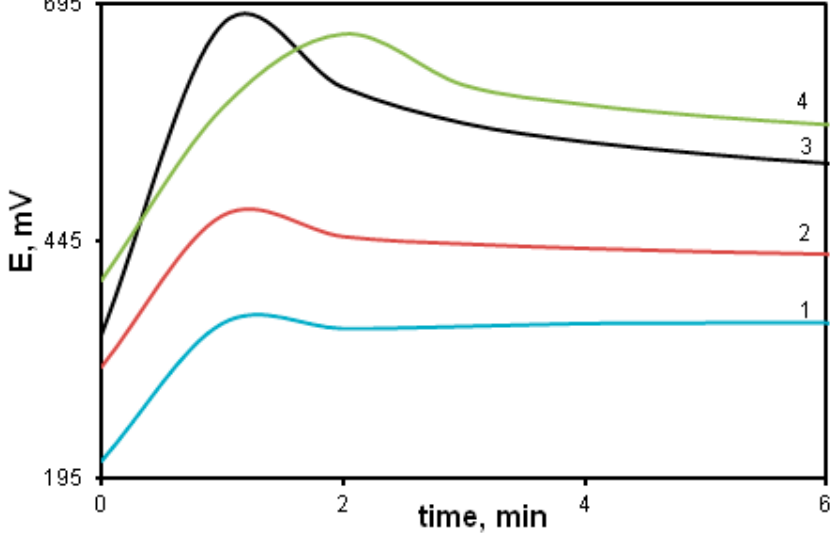
Figure 11. Time dependence of the redox potential during the DPDCB oxidation in different media: water (1), [HCl] = 0.1 mol/L (2), 0.5 mol/L (3); 1 mol/L (4).